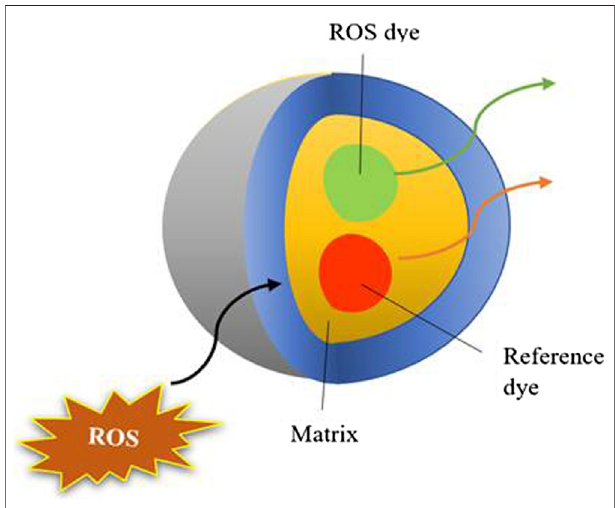
FIGURE 2 | Pictorial representation of fl uorescent dye utilized for assessing